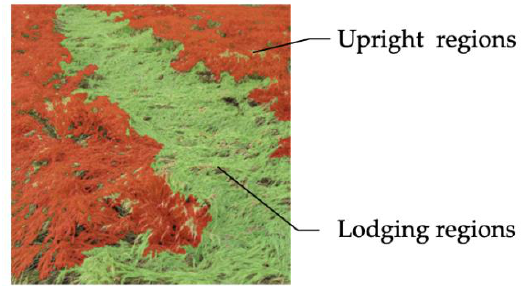
Figure 3. Wheat lodging regions.